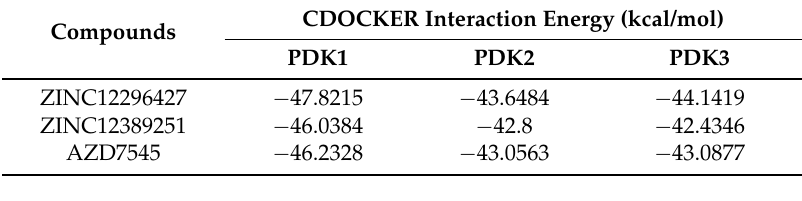
Table 4. CDOCKER interaction energy of compounds with pyruvate dehydrogenase kinases (PDKs).